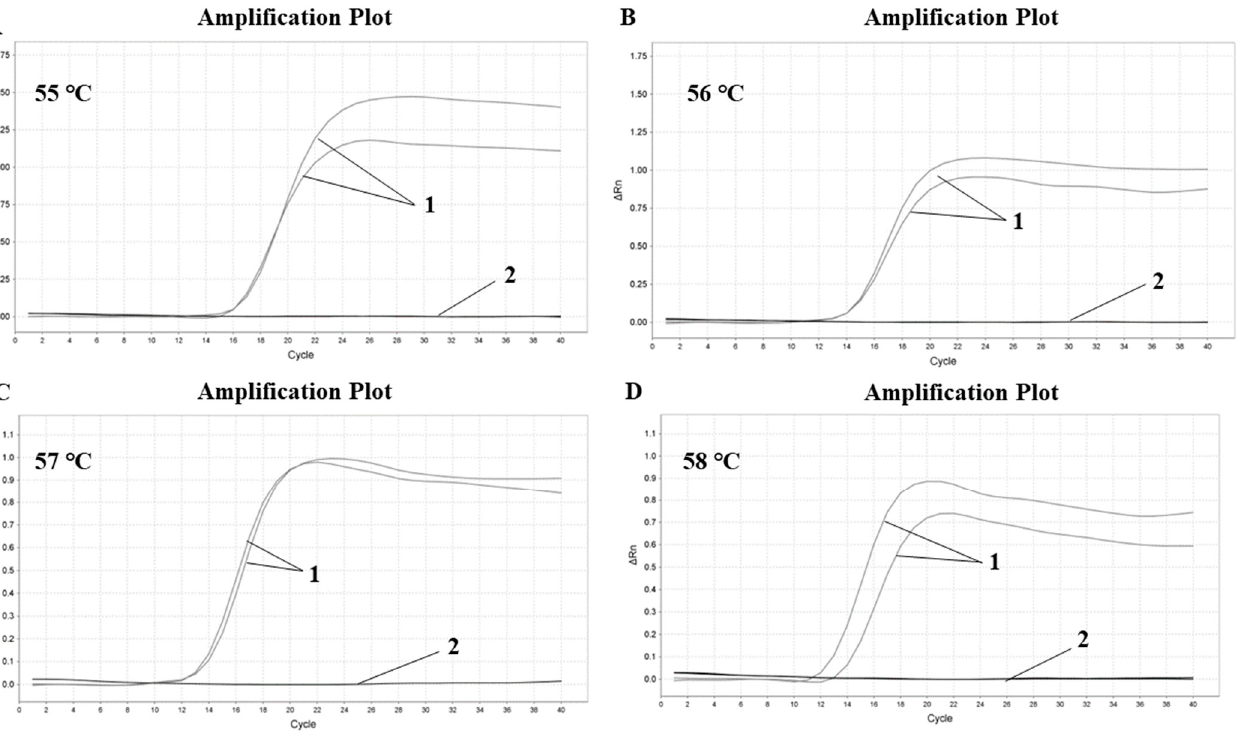
Figure 1. Optimization of Proofman–LMTIA reaction temperature for ITS gene in soybean. ( A ) 55 °C, ( B ) 56 °C, ( C ) 57 °C, ( D ) 58 °C. 1: positive controls (10 ng of gDNA from soybean); 2: negative controls (ddH 2 O).